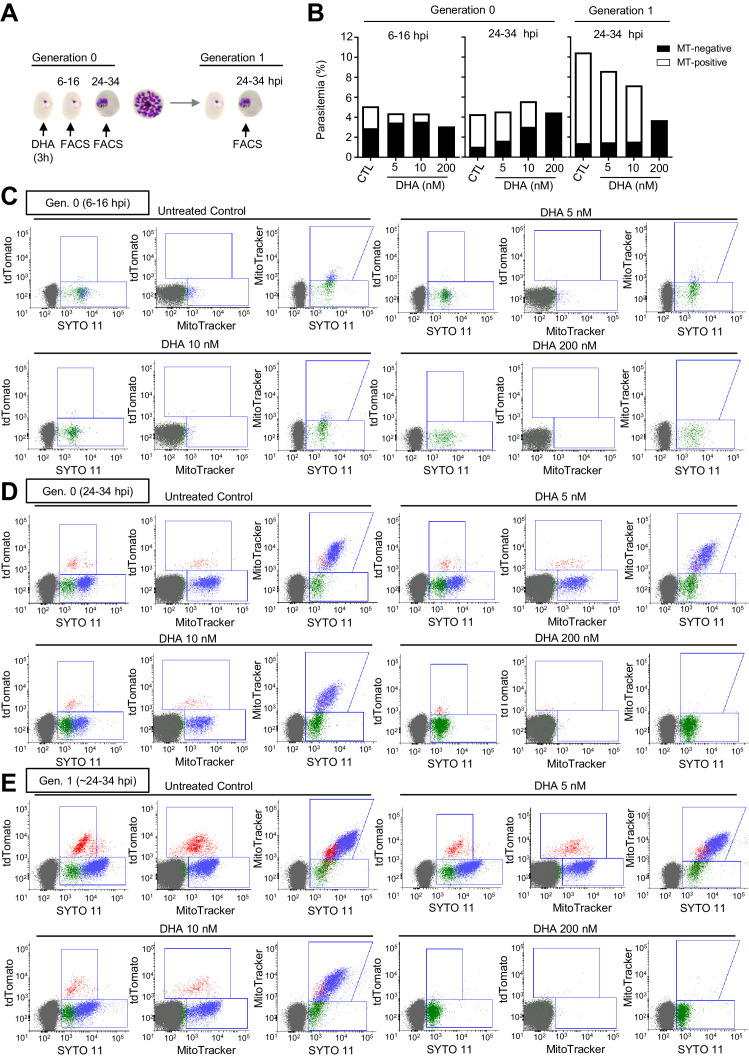
Flow cytometry set-up for the identification of viable parasites in the NF54-gexp02-Tom line using MitoTracker.(A) Schematic representation of the assay. Tightly synchronized cultures of the NF54-gexp02-Tom line were exposed to a 3 hr dihydroartemisinin (DHA) pulse at subcurative doses at the ring stage (0–10 hpi) or maintained under a lethal dose (200 nM, ‘kill’ control) for up to 48 hr. Flow cytometry measurements were performed at different times within the same cycle, and after reinvasion, as indicated. (B) Total parasitemia as determined using SYTO-11, and distribution of MitoTracker (MT) Deep Red FM-positive (viable) and –negative (non-viable and non-stained) parasites after DHA exposure. (C–E) Flow cytometry dot plots for MitoTracker Deep Red FM, SYTO 11, and TdTomato (marks gametocytes) at 6–16 hpi (C) and 24–34 hpi (D) of the same cycle of DHA treatment, and ~24–34 hpi of the next cycle (E). Some presumably healthy parasites were not stained with MitoTracker, as revealed by the presence of MitoTracker-negative/SYTO 11-positive parasites in the no-drug control (especially in ring-stage cultures).